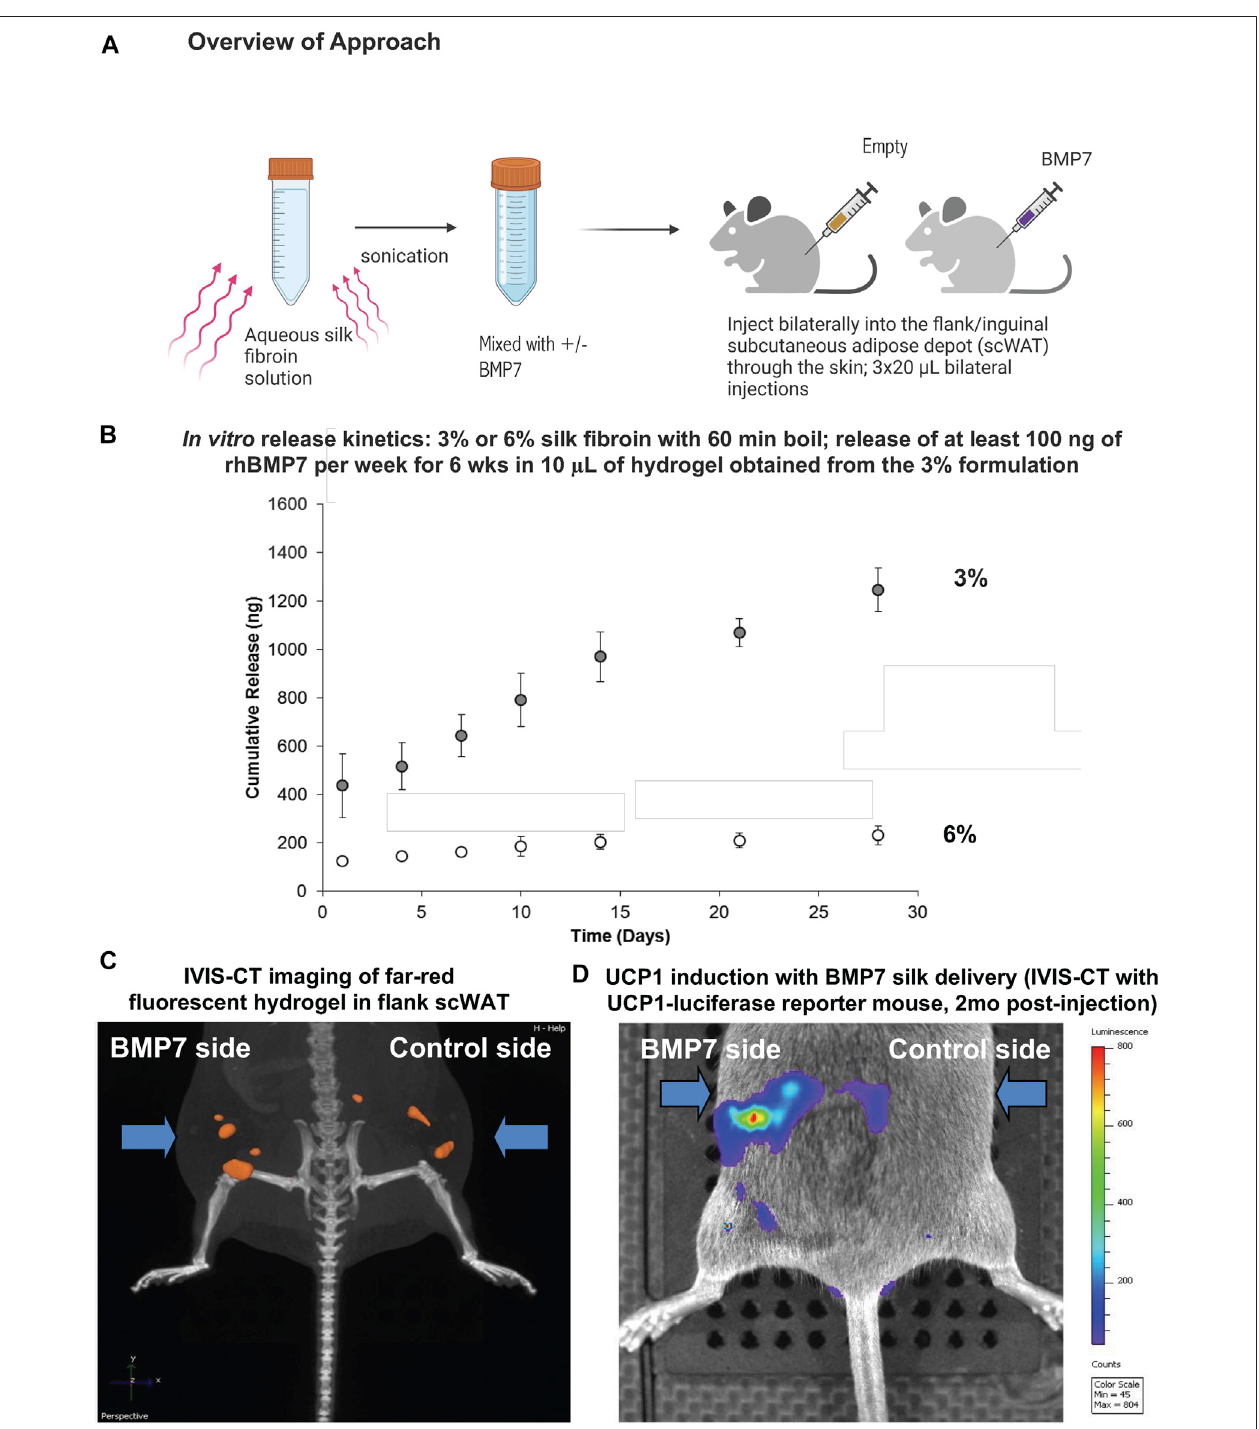
FIGURE1 | Silk hydrogels fordirect deliveryofBMP7 to scWAT. (A) Overview ofthe approach: aqueous silk fi broin solution ismixed with eitherBMP7 or vehiclein advance.Onthedayoftheinjection,thesolutionissonicatedinordertostartthegelationprocess.Thehydrogelremains fl uidwhenkeptonice.Injectionsareperformed through the skin, and we deliver three 20uL volumes of hydrogel per side, distributed anterior to posterior along the fl ank adipose depot. When the hydrogel reaches body temperature, it gels into place. (B) In vitro release kinetics con fi rmed that BMP7-loaded silk hydrogel released the target of at least 100 ng rhBMP7 per week foraperiodof6 weekswhenusinga10 μ Lhydrogelsample(ELISAdataforBMP7).Datareportedisfora20 μ Lhydrogel.The3%silkhydrogelformulationachievesthe desiredreleaseoutcomes. (C) IVIS-CTimagingofaUCP1-Cre/Rosa-luciferasereportermouse,showingthefar-red fl uorescenceoftheinjectedsilkhydrogelinthe fl ank scWAT depots bilaterally. Representative image from N = 3 mice. (D) IVIS-CT imaging of a UCP1-Cre/Rosa-luciferase reporter mouse, showing UCP1 induction on the BMP7 side only (highest expression in red), 2 months post-injection. Representative image from N = 3 mice.